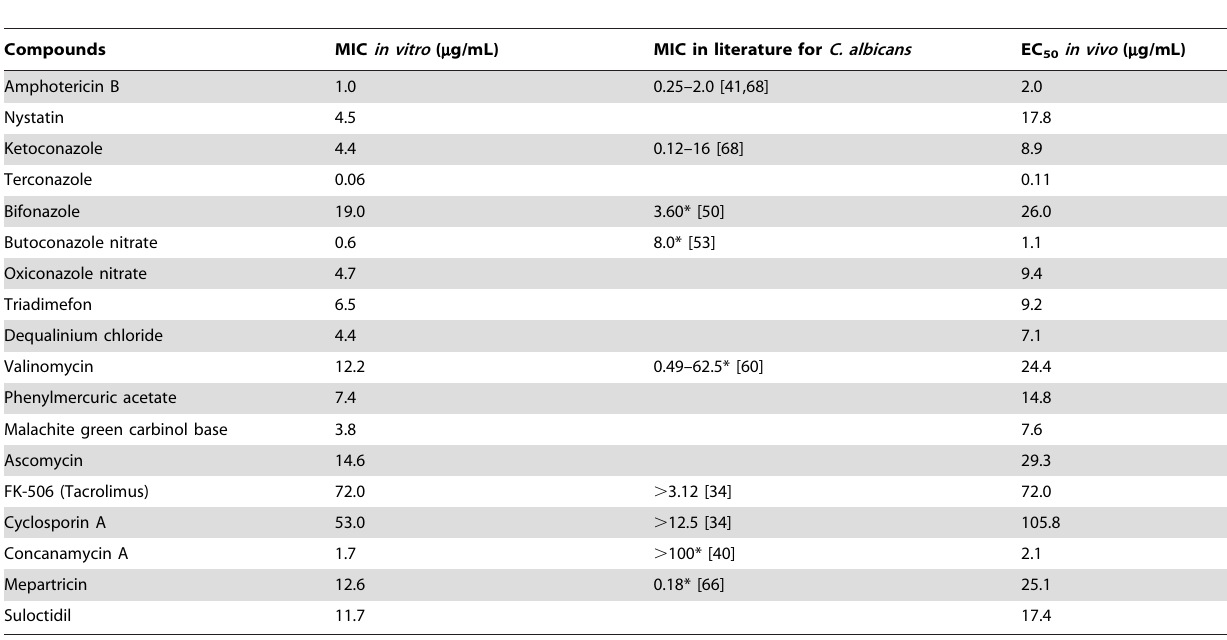
Table 2. Minimal inhibitory concentrations (MIC) in vitro and effective concentration (EC 50 ) in vivo of compounds identified in the C.elegans - C. albicans screen.